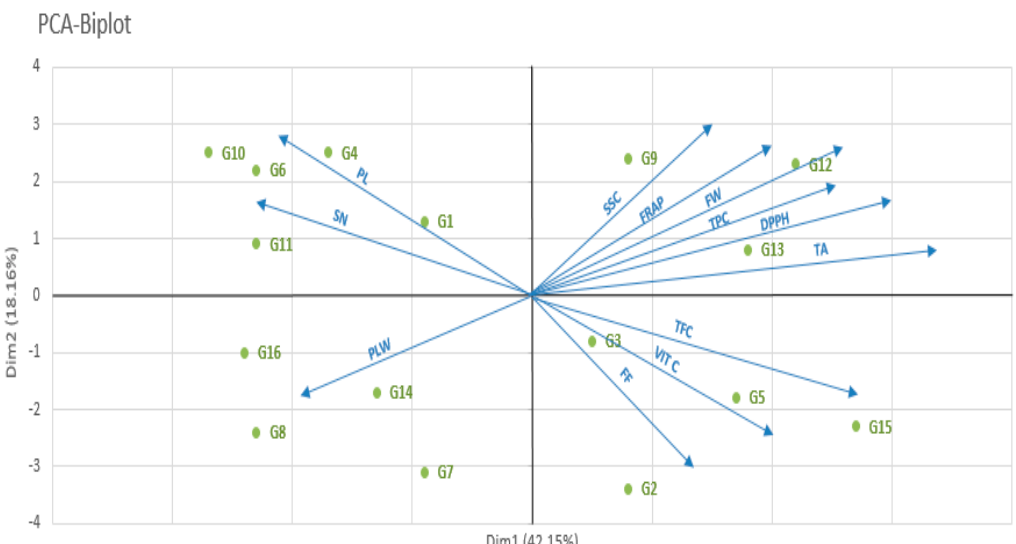
Figure 2. Distribution of oleaster-leafed pear genotypes according to agro-morphological characteristics. FW: Fruit weight; SN:Seed number; PL: Pedicel length; FLW: Fruit length/width; FF: Fruit firmness; SSC: Soluble solid content; TA: Titratable acidity; Vit.C: Vitamin C; TPC: Total phenolic content; TFC: Total flavonoid content; FRAP: Ferric Reducing